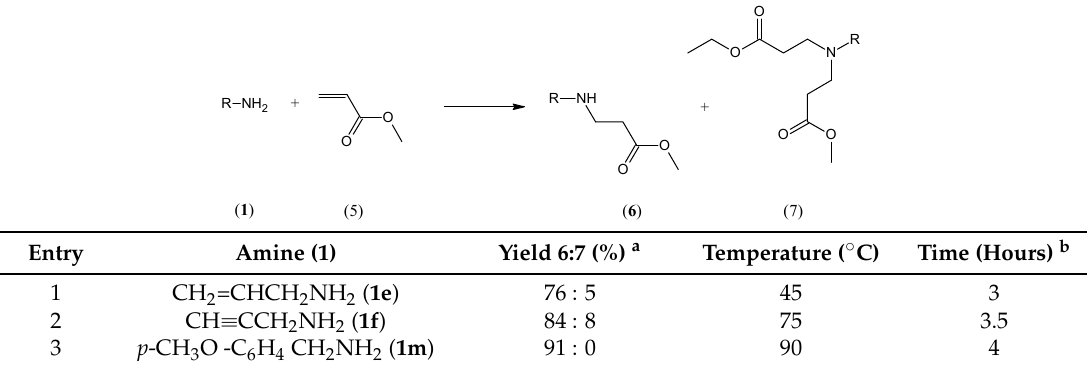
Table 2. Yields and conditions for mono-addition of various primary multi-functional amines with methyl acrylate ( 5 ).